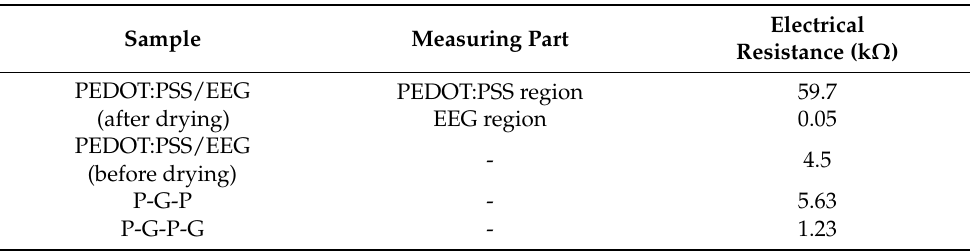
Table 1. Average electrical resistances of the PEDOT:PSS/EEG composite electrodes based on CIW conditions.